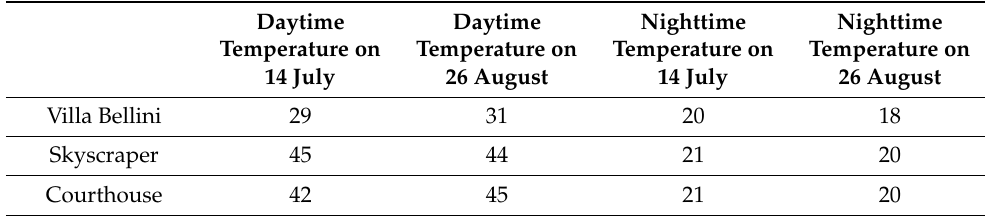
Figure 8. Daytime ( a ) and nighttime ( b ) LST differences on 26 August 2017. Looking at the atmospheric temperatures measured by the WS1 on these days, the green areas have temperatures 2–3 ◦ C lower than the surrounding areas. Thus, it is possible to assert that the green areas in addition to the evapotranspiration effect, further contribute to cooling down the environment through sensible heat fluxes. On the contrary, the built- up areas have LST temperatures 15–17 ◦ C higher than the atmospheric temperatures. This outcome indicates that the very hot pedestrian surface contributes to the increase of surrounding air temperature. As a further analysis, we considered some reference buildings/areas of Catania (“Villa Bellini”, the highest building of the city, namely the skyscraper, and the courthouse) and evaluated the LST during these two days (Table 3). Table 3. LST for the chosen references buildings/areas on 14 July and 26 August 2017. Temperatures are in ◦